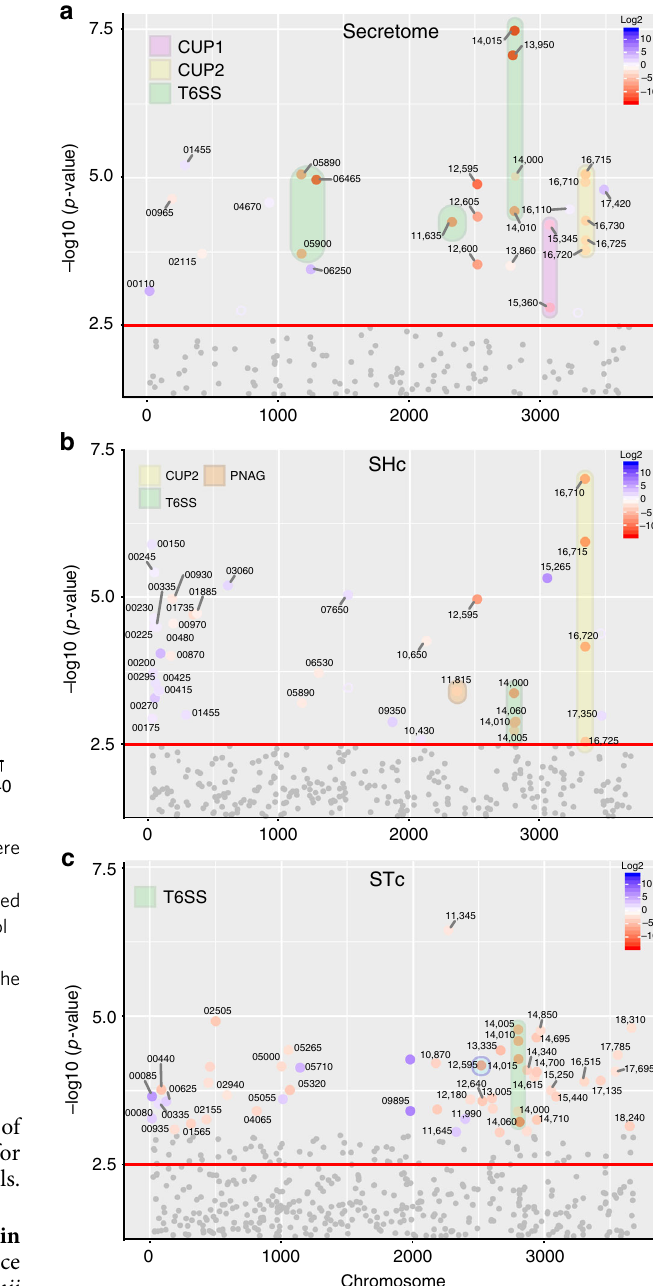
Fig. 6 pAB5 modulates chromosomally-encoded proteins. Quantitative proteome analysis of the effect of pAB5 on the secretome ( a ), the whole proteome with shaking ( b ), and whole proteome under static conditions ( c ). Manhattan plots demonstrating the signi fi cance of protein alteration, – log10( p -value), vs position in the genome are shown. The direction of the protein alteration is colored coded according the provided heat map. Selected proteins and accession numbers are shown. Full data sets are shown in Supplementary Fig. 7. Pink shadow highlights the genes encoding for CUP1 pili, yellow shadow highlights the genes encoding for CUP2 pili, orange shadow highlights the genes of PNAG biosynthetic pathway and green shadow highlights the genes encoding for the T6SS. Four biological replicates of each condition were analyzed. The default Maxquant FDR setting of 1% FDR at the protein and peptide levels were